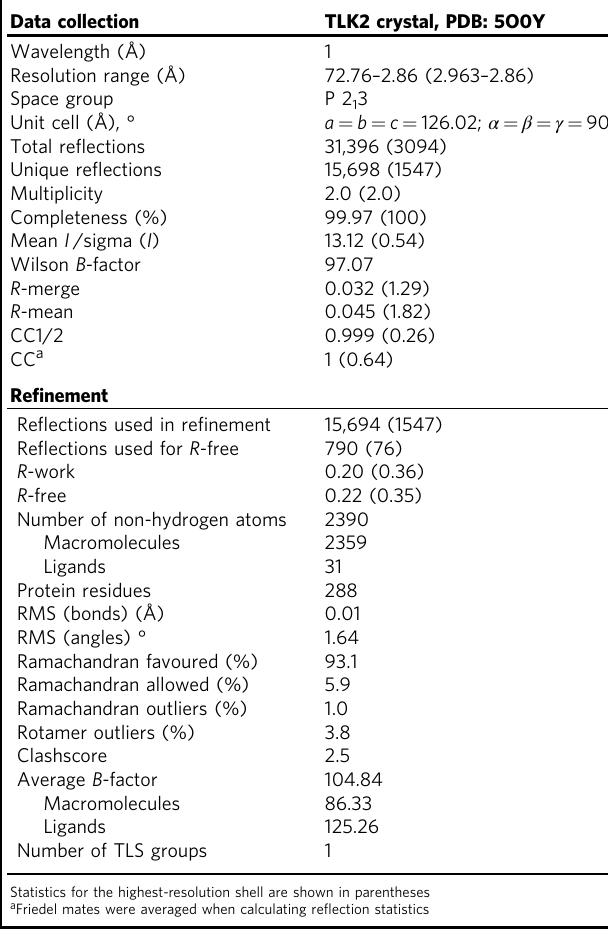
Table 1 Crystal structure of TLK2 kinase domain,